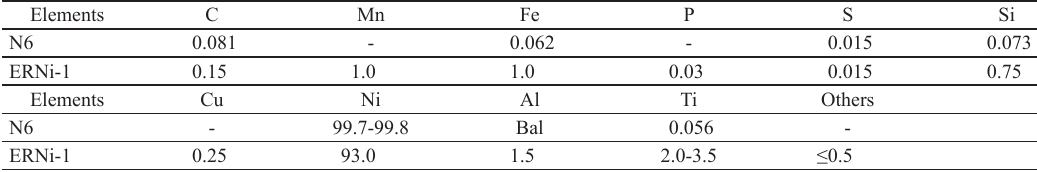
Table 1. The chemical composition of the N6the and ERNi-1(Wt, %) Elements